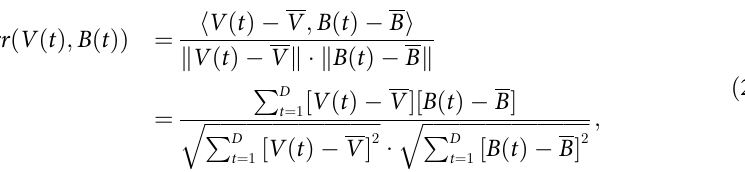
word-of-mouth and on-demand streaming,